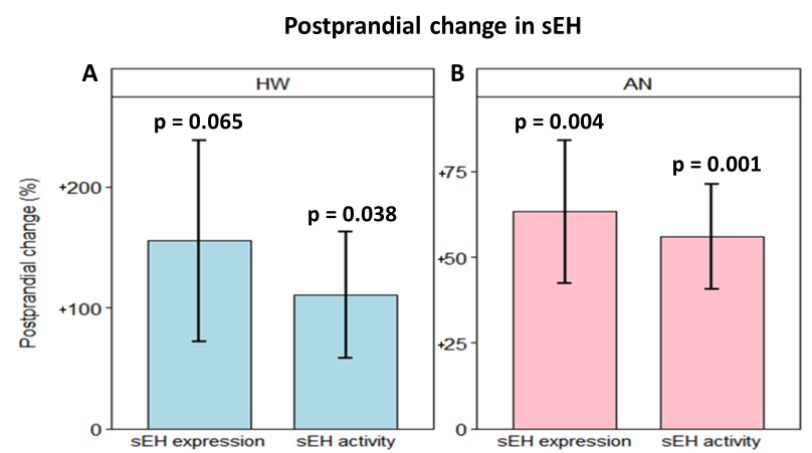
Figure 3. Bar plots of postprandial changes (%) in sEH expression and sEH activity in ( A ) healthy women and ( B ) women with anorexia nervosa at 2-h after consumption of the study meal. Bars and error bars represent the mean and standard error of the mean, respectively. p represents the p value of one-sample t -test for each study group, separately. HW: healthy women; AN: anorexia nervosa. In the AN group, fasting mean sEH expression was 67.96 ± 48.28 ng/mL (95% CI: 56.44 to 79.47 ng/mL, Figure 2A), and mean sEH activity was 295.15 ± 200.67 pmol/min.mL (95% CI: 247.31 to 343.00 pmol/min.mL, Figure 2B). Two hours after eating, sEH expression